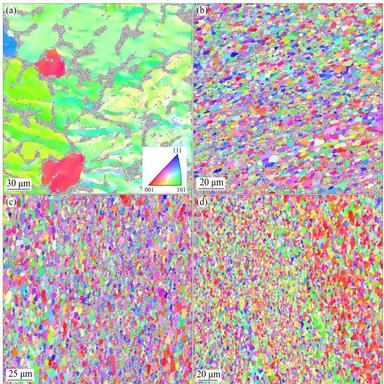
EBSD maps of AA2124/4wt.%B4C nano-composite (a) and composite coatings at different rotational speeds: (b) 600 r/min; (c) 800 r/min; (d) 1000 r/min